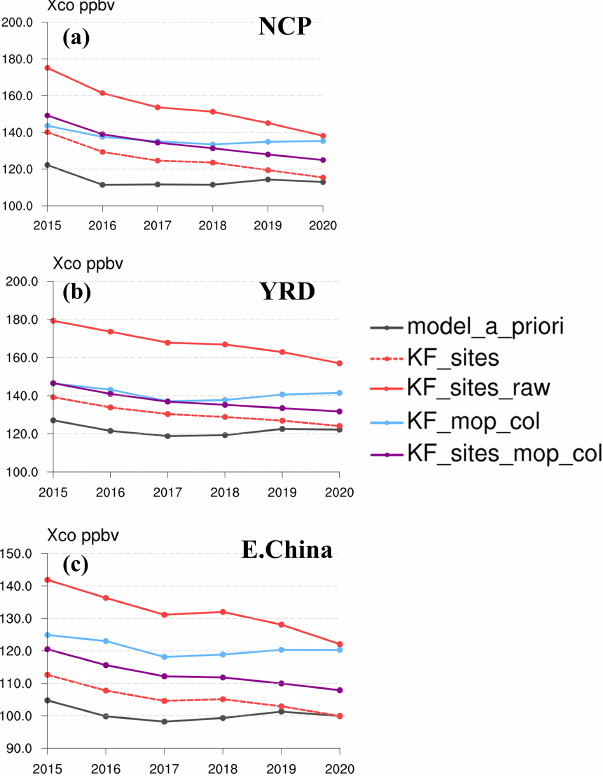
Figure 7. CO columns (Xco) in 2015–2020 from a priori simu- lations (black line), Kalman filter, by assimilating MOPITT CO columns (blue line), MEE CO (raw data: red solid line; normal- ized data: red dashed line) and MOPITT CO column + normalized MEE CO (purple